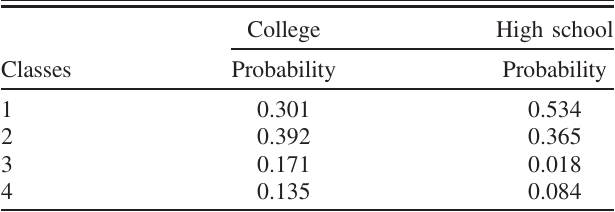
TABLE VI. Class probabilities using the 4-class model fit for college and high school students.